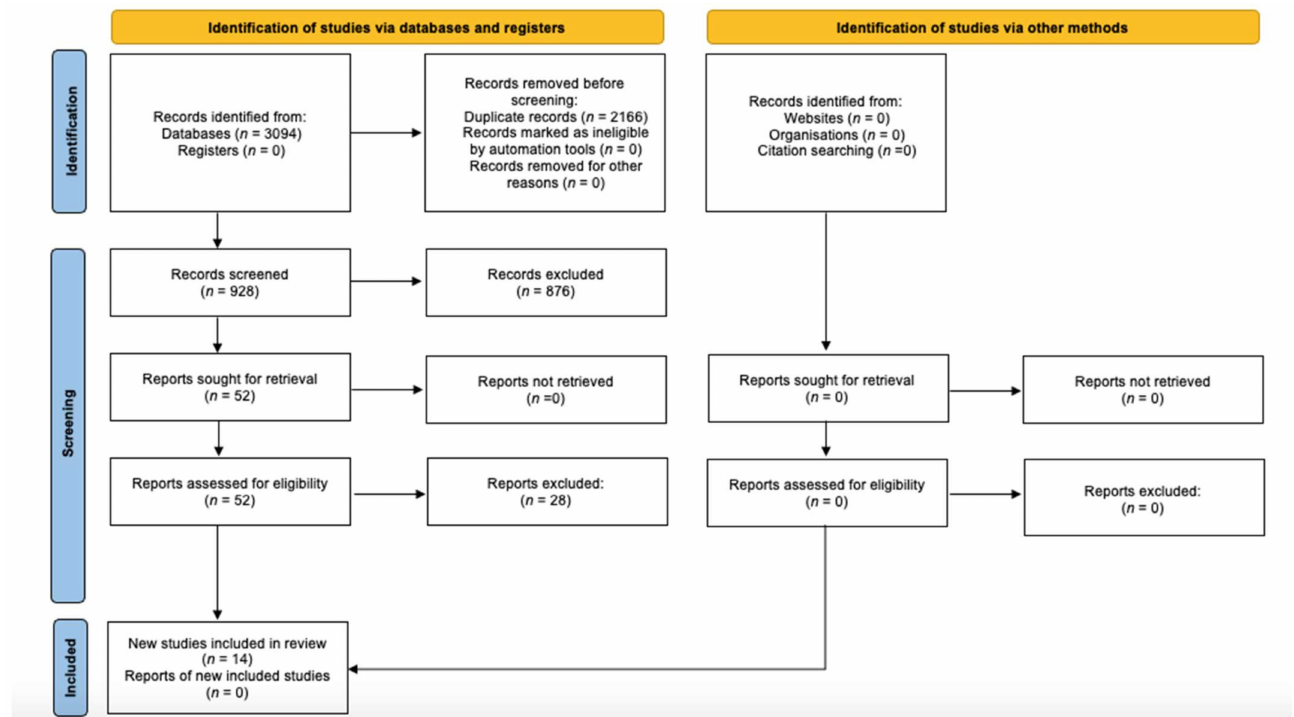
Figure 1. Literature search flowchart (PRISMA